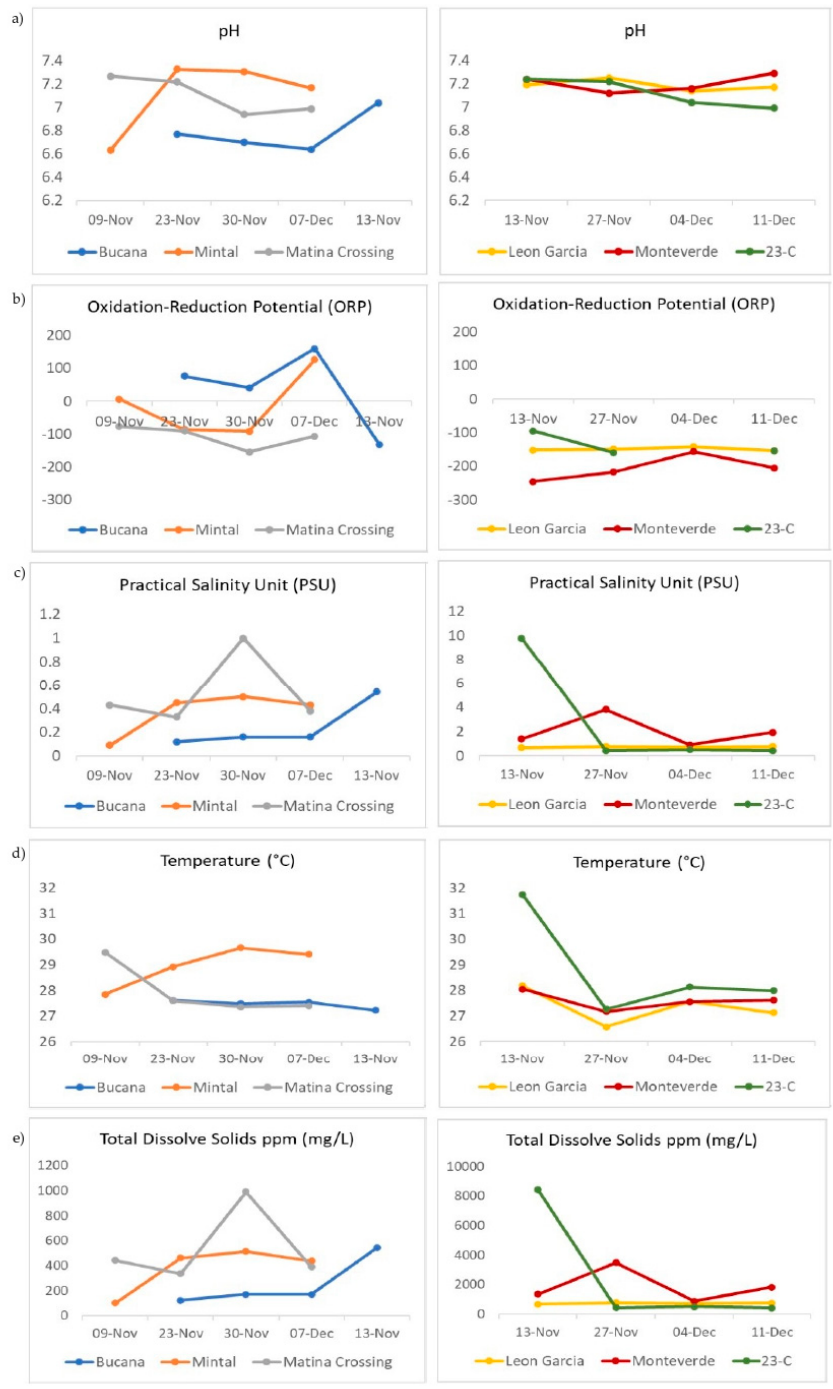
Figure 2. Physico-chemical parameters measured using Hanna multiprobe (hi-98194) during sample collection. The ranges of the specific parameters measured and the accuracy of measurements are indicated in the following: ( a ) pH is 0.00 to 14.00 pH with a resolution of 0.01 pH, accuracy of ± 0.02 pH, ( b ) Oxidation-Reduction Potential (ORP) values are ± 2000.0 mV with a resolution of 0.1 mV, accuracy of ± 1.0 mV, ( c ) salinities within 0.00 to 70.00 PSU with a resolution of 0.01 PSU, accuracy of ± 2% of reading or ± 0.01 PSU whichever is greater, ( d ) temperature is from − 5.00 to 55.00 ◦ C with a resolution of 0.01 ◦ C, accuracy of ± 0.15 ◦ C, and ( e ) the Total Dissolved Solids (TDS) is 0 to 400,000 ppm (mg/L), with the maximum value depending on the TDS factor, which was set automatic ppt (g/L), accuracy of ± 1% of reading or ± 1 ppm (mg/L) whichever is